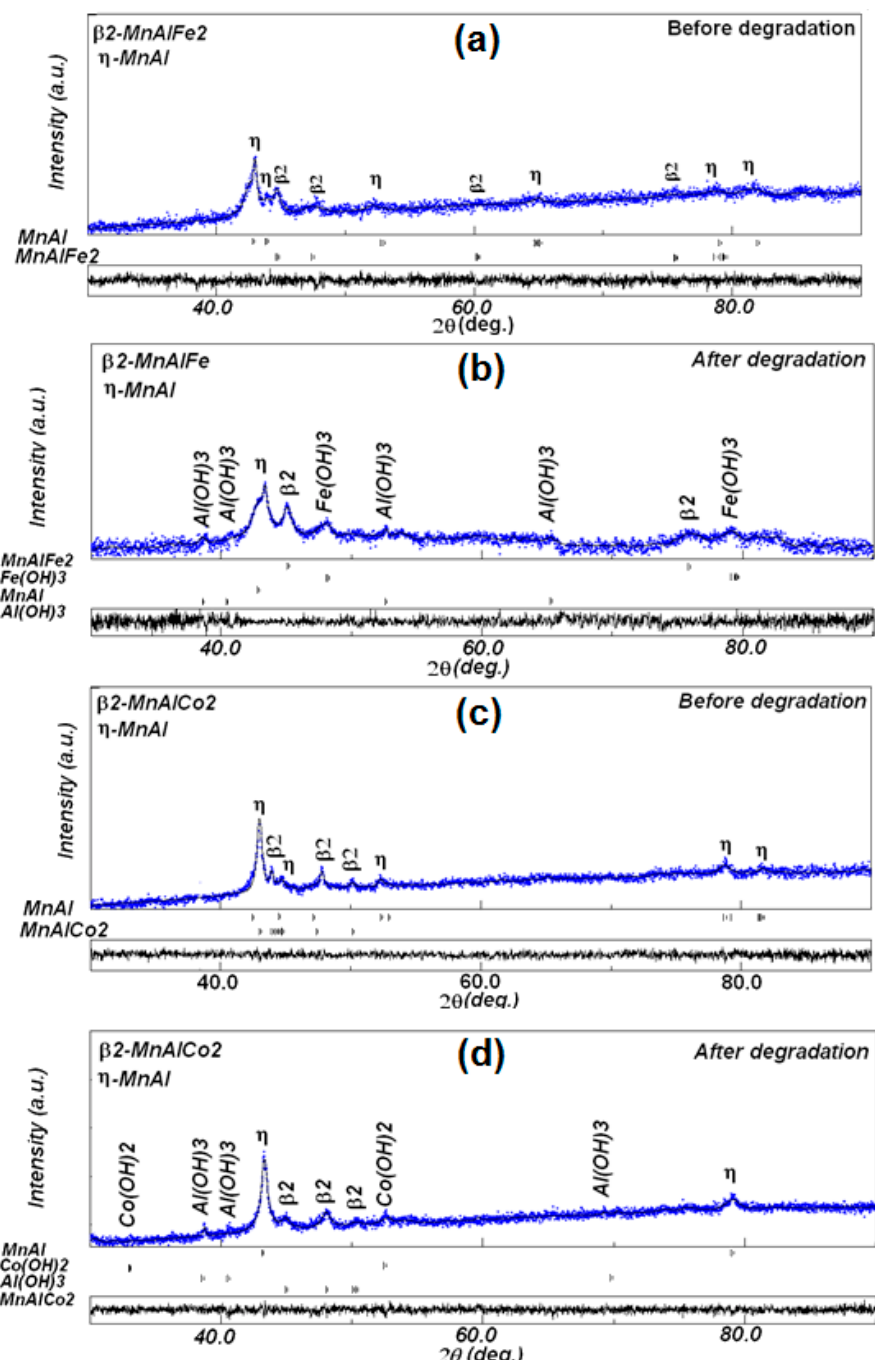
Figure 8. XRD diffraction patterns: ( a , b ) MA Mn-Al-Fe powder before and after degradation and ( c , d ) MA Mn-Al-Co powder before and after degradation.